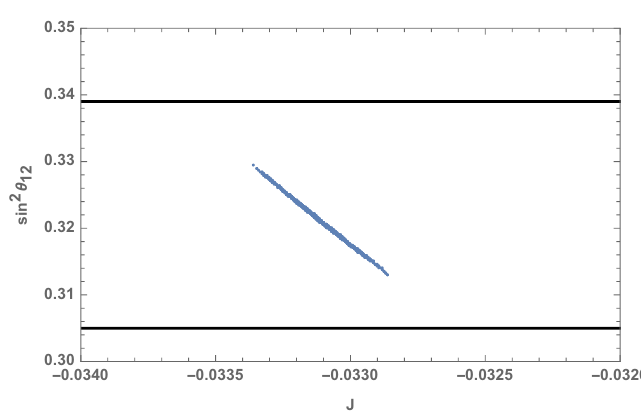
Figure 2 . Correlation between the solar mixing parameter sin 2 (cid:18) 12 and the Jarlskog invariant for the case of inverted neutrino mass hierarchy. The horizontal lines are the minimum and maximum values of the solar mixing parameter sin 2 (cid:18) 12 inside the 1 (cid:27) experimentally allowed range.